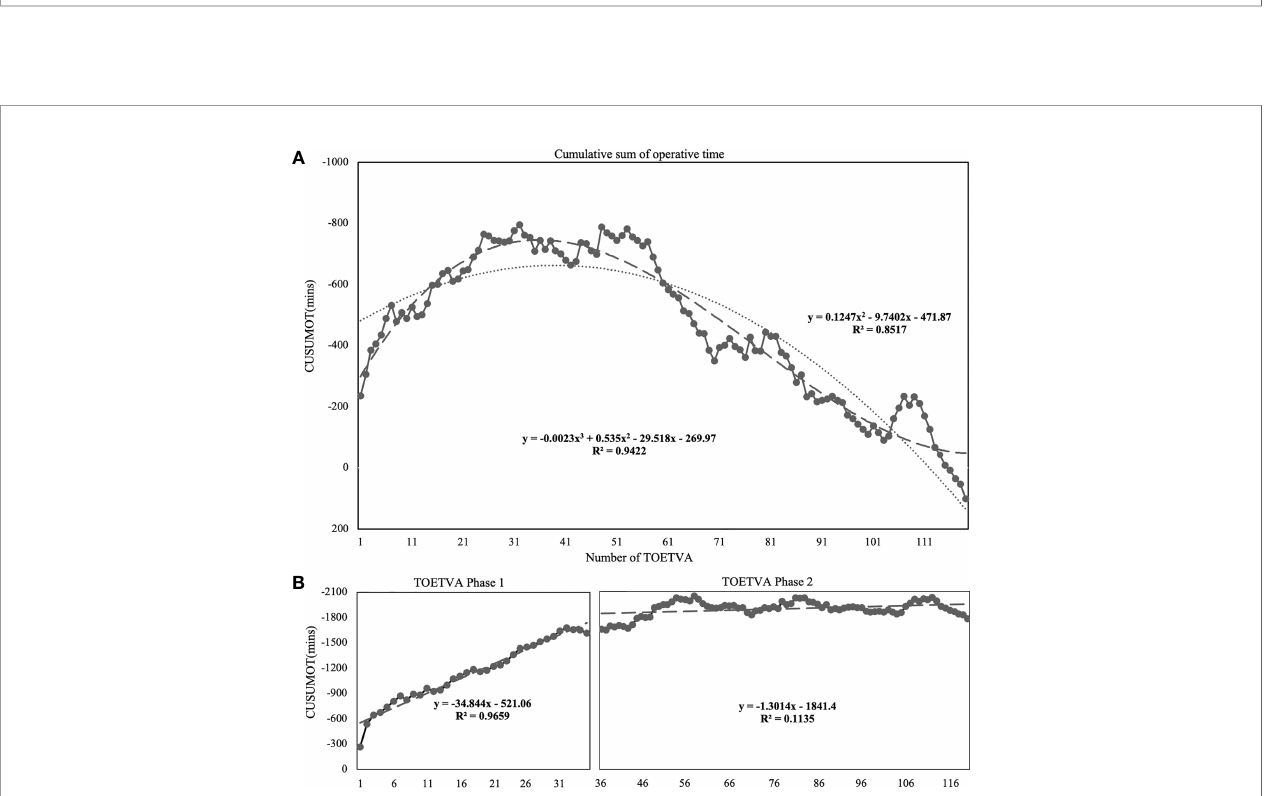
FIGURE 2 | Learning curve for TOETVA using cumulative sum (CUSUM) method. (A) CUSUM of operation time plotted against number of TOETVA (solid line with marked point). The dashed line represents the curve of best fi t for the plot as a third-order polynomial using the equation CUSUM OT = − 0.0023 × patient number 3 + 0.535 × patient number 2 − 29.518 × patient number − 269.97, R ² = 0.9422. The dotted line represents the curve using a second-order polynomial using the equation CUSUM OT = 0.1247 × patient number 2 − 9.7402 × patient number − 471.87, R ² = 0.8517. (B) According to the change in the slope, the cutoff points of the two phases were best calculated as 35.90 (third-order polynomial). Lines of the best fi t for the two phases of the CUSUM OT learning curves included 35 and 84 cases,